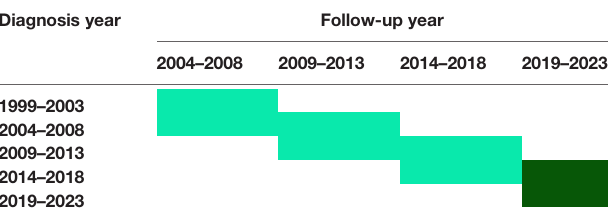
TABLE 1 | Schematic diagram of the model-based period